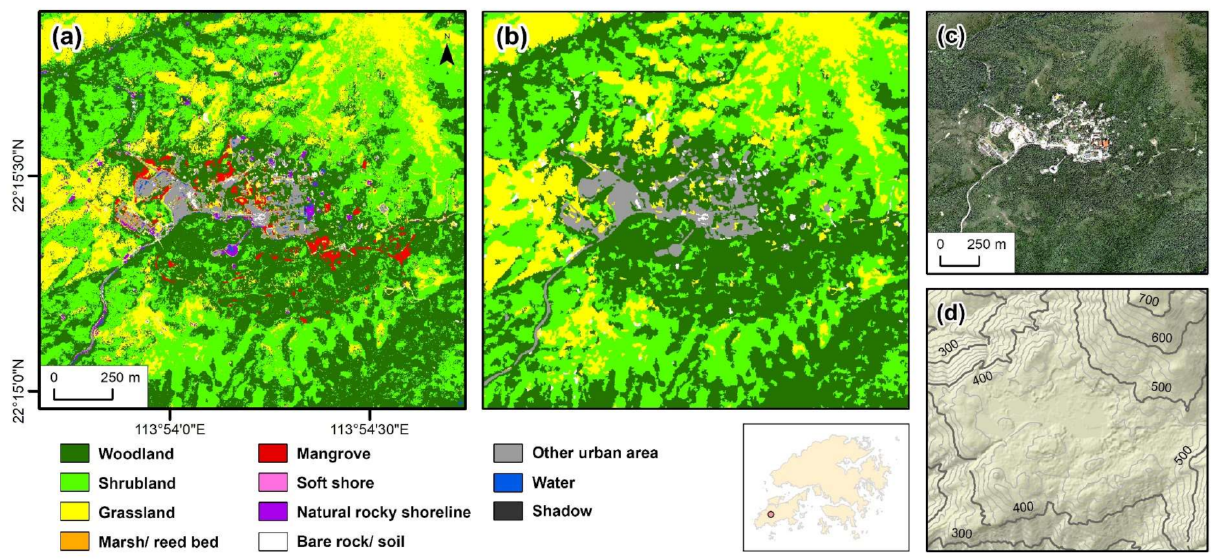
Figure 4. A selected area of classification map before and after applying the modification rules in stage 2; ( a ) initial classification result in stage 1 produced using pixel-based RF method; ( b ) refined classification map in stage 2; ( c ) true-colour composite of the WorldView image; ( d ) topographic map of the same area.